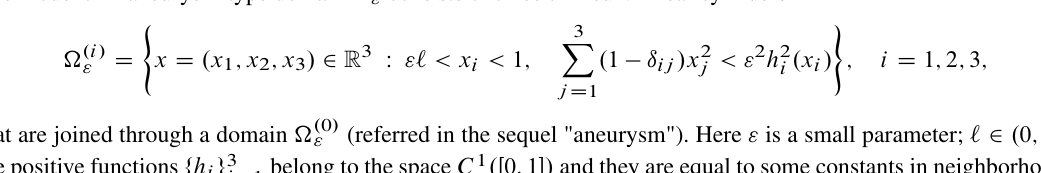
Fig. 1. The aneurysm (cid:127) .0/ "